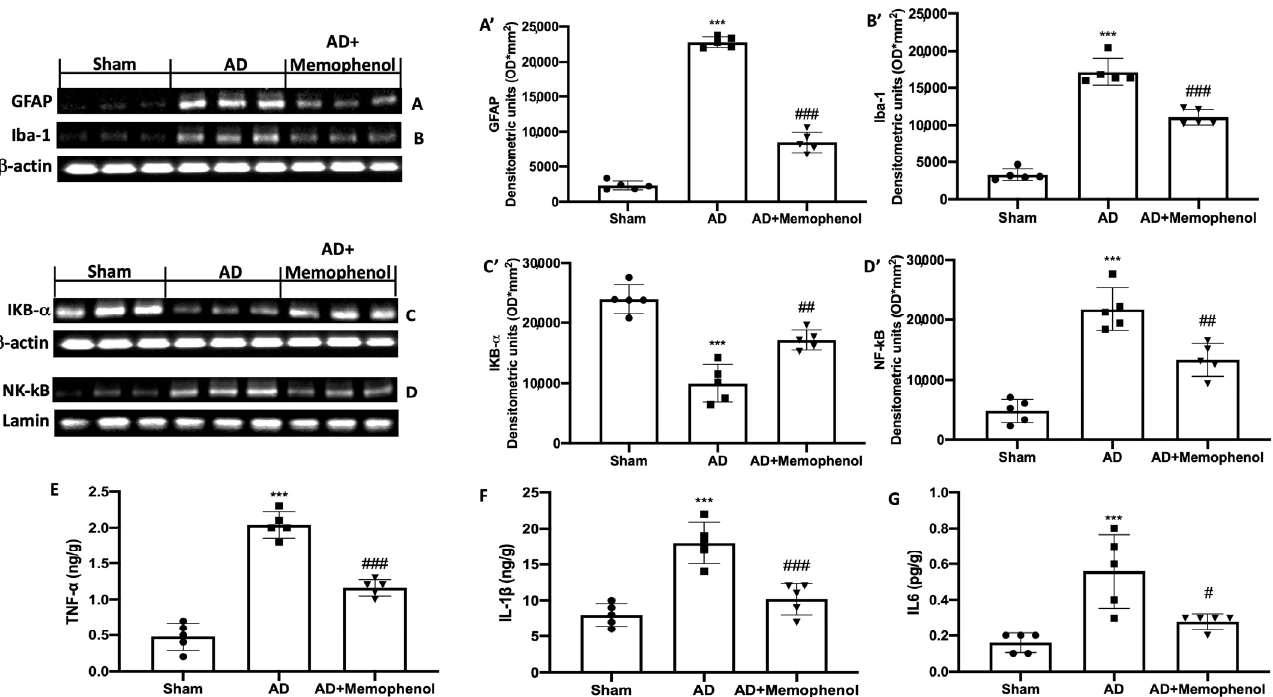
Figure 4. The e ff ects of Memophenol TM on the activation of astrocytes and microglia and on the NF- Figure 4. The effects of Memophenol TM on the activation of astrocytes and microglia and on the κ B pathway following AlCl 3 injection. Western blot analyses of GFAP ( A ), Iba-1 ( B ), IkB- α ( C ), and NF- κ B pathway following AlCl 3 injection. Western blot analyses of GFAP ( A ), Iba-1 ( B ), IkB- α ( C ), NF- κ B ( D ) expression with related densitometric analysis ( A ’– D ’); ELISA kit of TNF- α ( E ), IL-1 β ( F ), and NF- κ B ( D ) expression with related densitometric analysis ( A ’– D ’); ELISA kit of TNF- α ( E ), IL-1 β and IL-6 ( G ) levels. For the Western blot and ELISA analyses, n = 5 rats from each group and for ( F ), and IL-6 ( G ) levels. For the Western blot and ELISA analyses, n = 5 rats from each group and for each analysis were employed. A p -value of less than 0.05 was considered signi fi cant. *** p < 0.001 each analysis were employed. A p -value of less than 0.05 was considered significant. *** p < 0.001 versus Sham, # p < 0.05 versus AD, ## p < 0.01 versus AD, ### p < 0.001 versus AD. versus Sham, # p < 0.05 versus AD, ## p < 0.01 versus AD, ### p < 0.001 versus